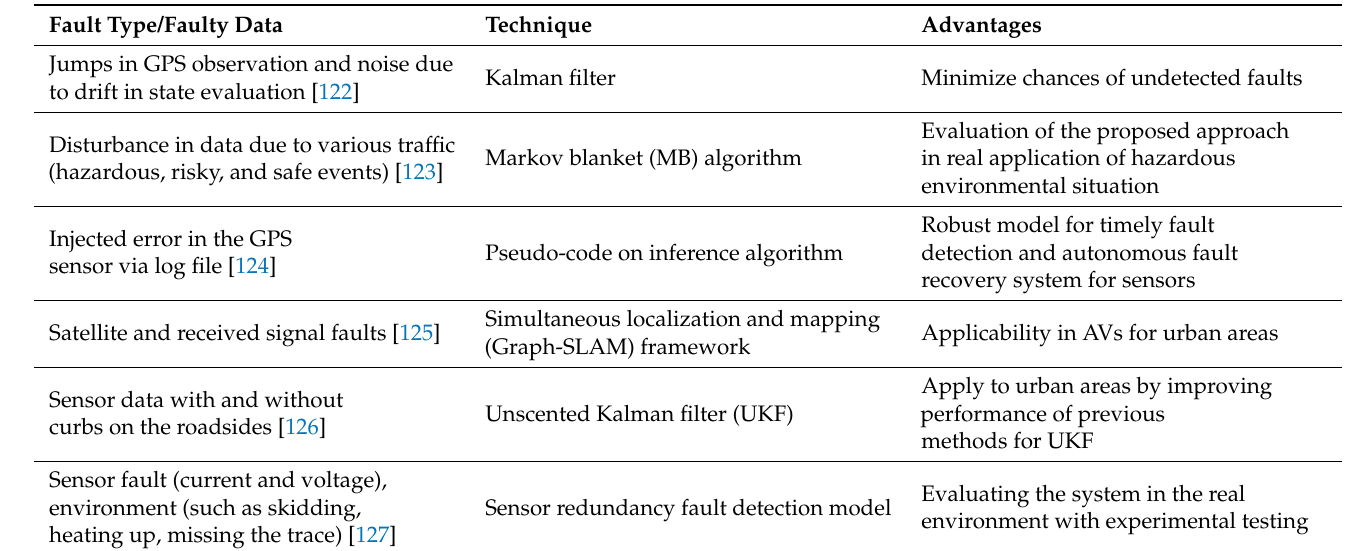
Table 8. Summary of global navigation satellite system (GNSS) system fault detection and isolation.